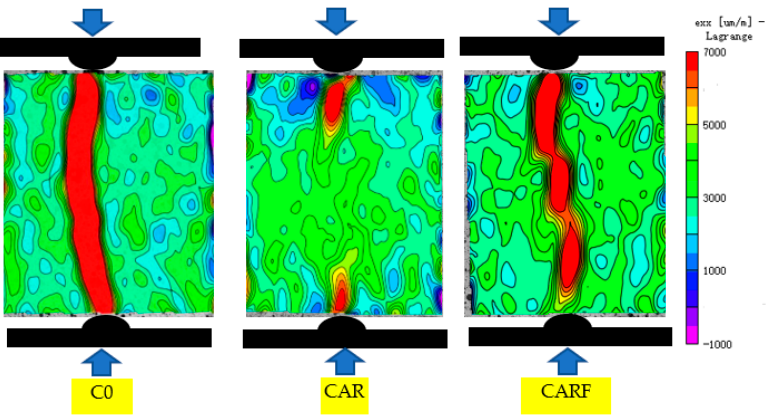
Figure 7. Strain fields under compressive loads of specimens incorporating toughening materials.